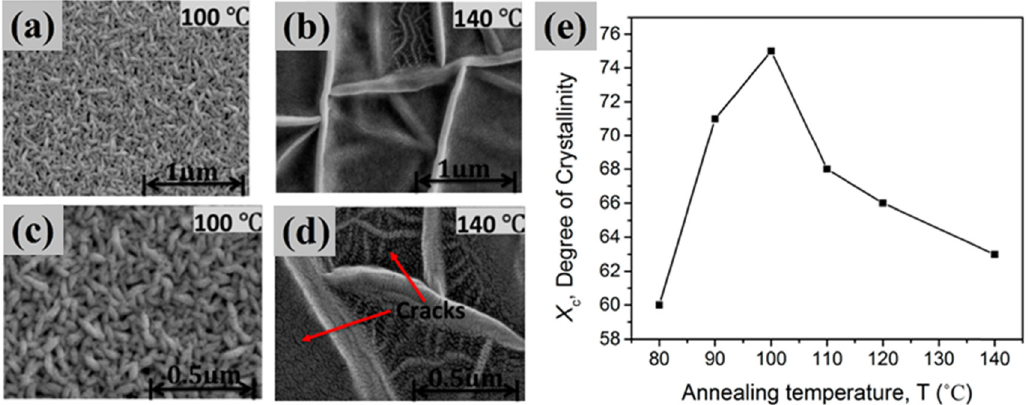
Figure 13: FESEM ( fi eld electron scanning electron microscope ) images of annealed PVDF - TrFE samples at ( a ) 100°C and ( b ) 140°C; ( c ) an enlarged section of ( b ) ; ( d ) an enlarged section of ( b ) ; ( e ) dependence of the degree of the crystalline structure as a function of annealing temperature [ 19 ] .